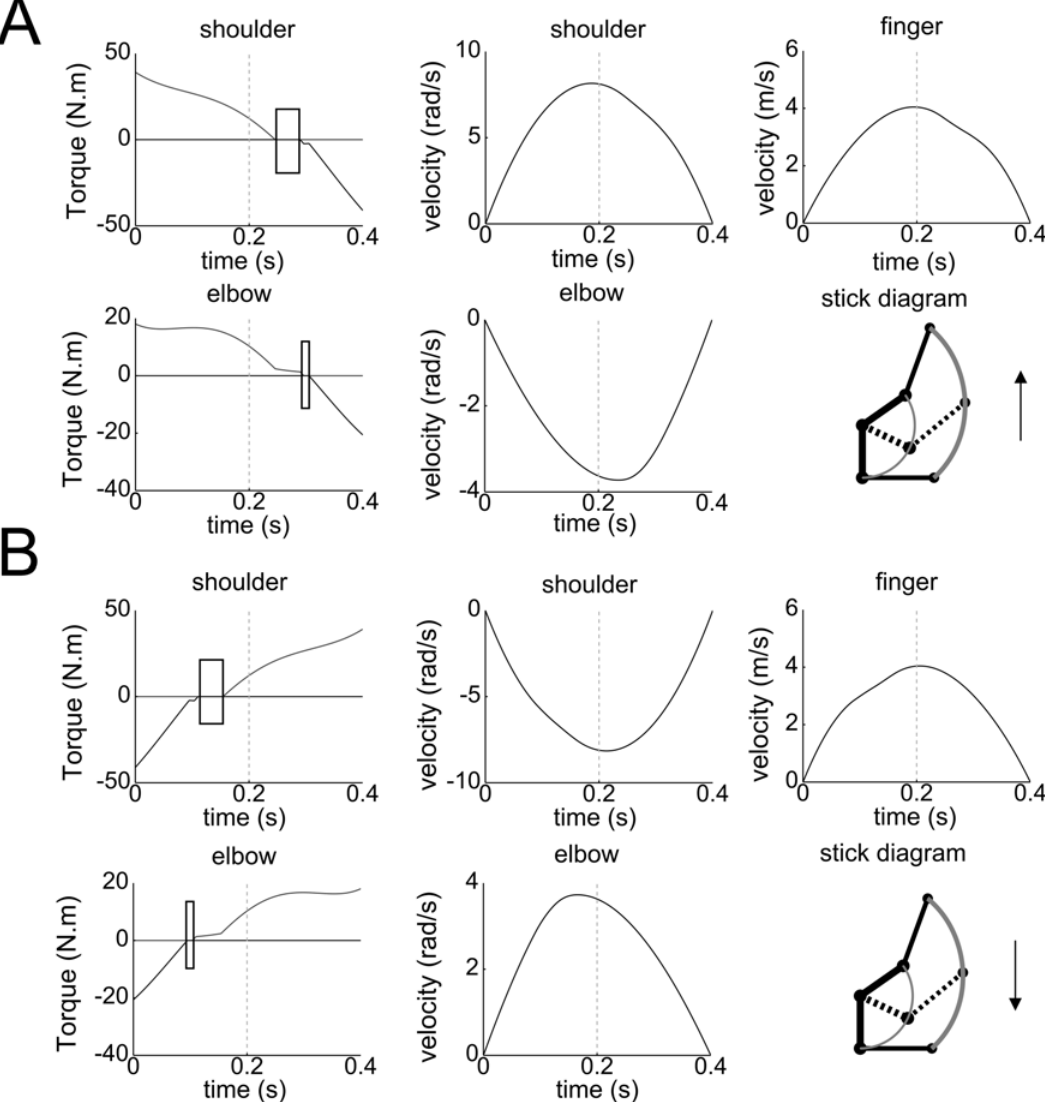
Figure 2. Results for a simulated 2-dof arm movement. (A) Upward direction. (B) Downward direction. Torques and angular velocities, respectively noted u (N.m) and y (rad/s), are plotted with respect to time (seconds), along with the finger velocity (m/s). The successive inactivation periods at each joint and the asymmetries of the velocity profiles are clearly visible.